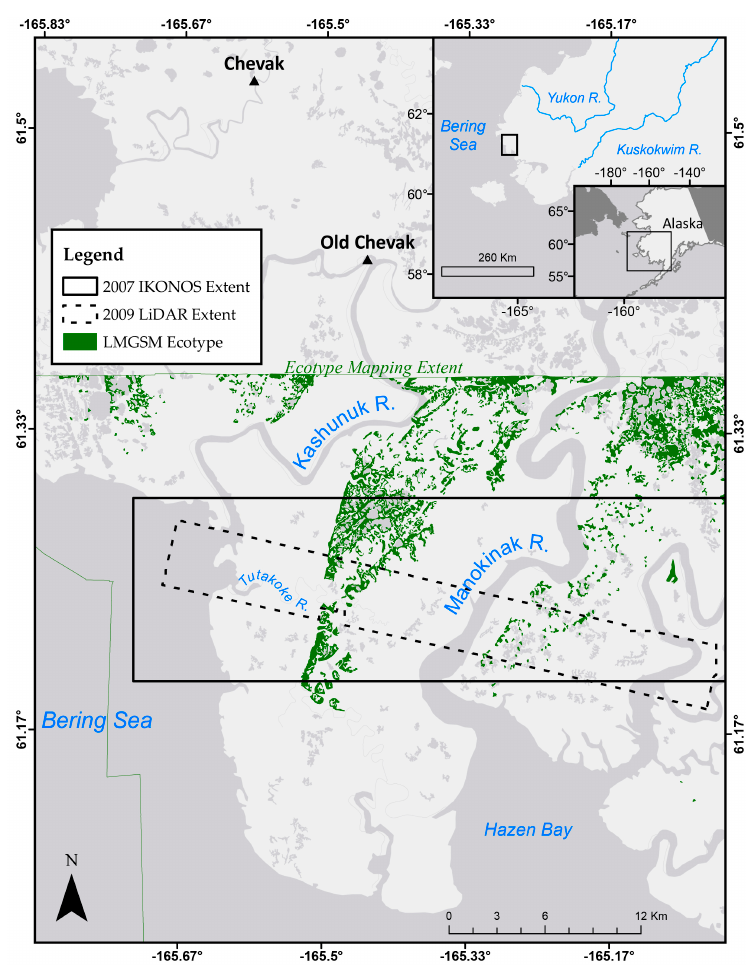
Figure 1. Study Area located on the Yukon-Kuskokwim Delta (YKD) in western Alaska, USA. Depicted are the extent of the 2007 IKONOS data (solid line), the extent of the 2009 LiDAR data (dashed line), and the approximate distribution of the Lowland Moist Graminoid Shrub Meadow (LMGSM) ecotype (green) that is associated with permafrost plateaus [5]. This landscape is at the southern extent of permafrost in Alaska, and lies in the sporadic to isolated permafrost zone [2]. The mean annual air temperature (MAAT) 200 km east of the study area